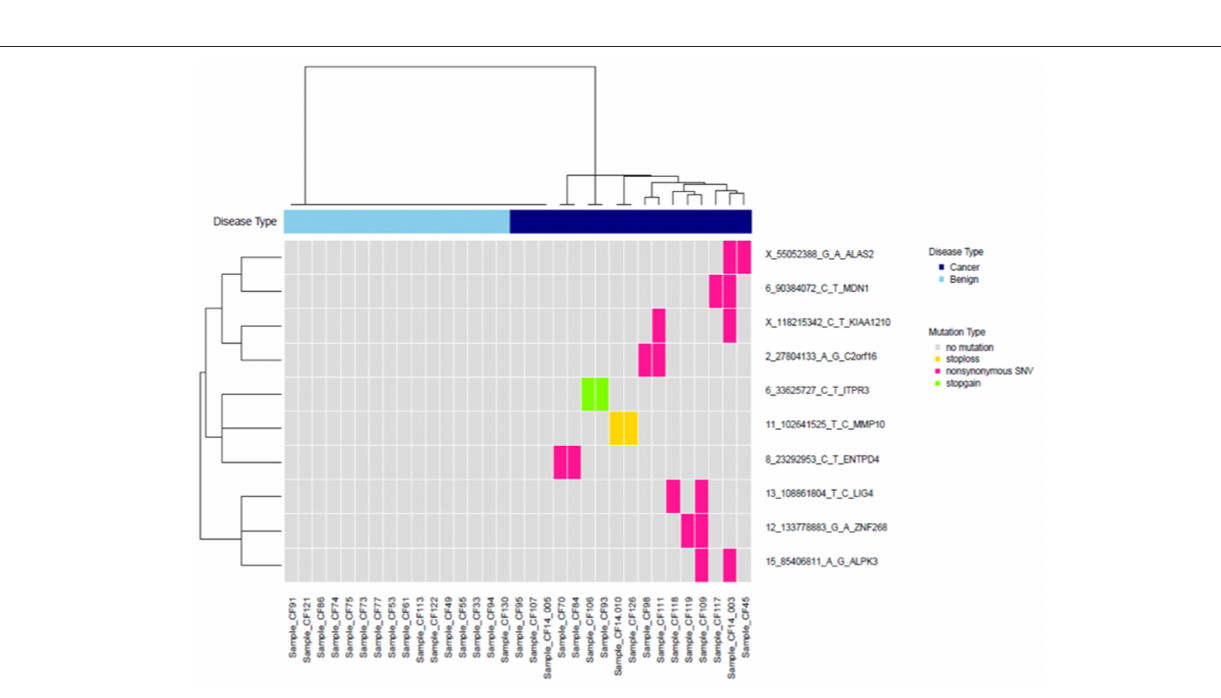
Frontiers in Oncology | www.frontiersin.org